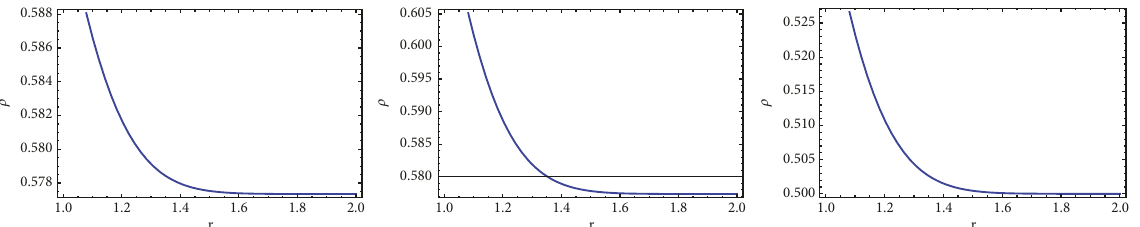
Figure 1: This figure represents the variation of 𝜌 versus 𝑟 (km) for the strange star taking 𝛽 = 1 , 𝛽 = 2 , and 𝛽 = 3 .